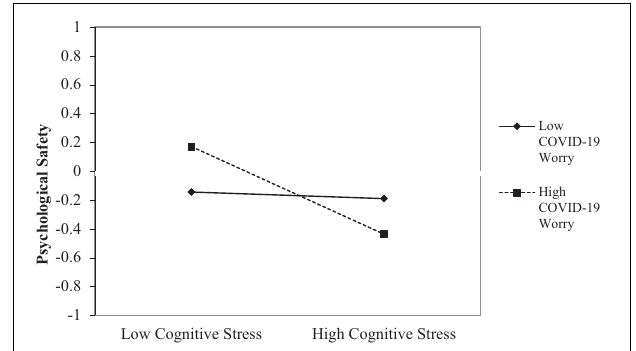
FIGURE 2 | Moderation of COVID-19 worry on the effect of cognitive stress on psychological